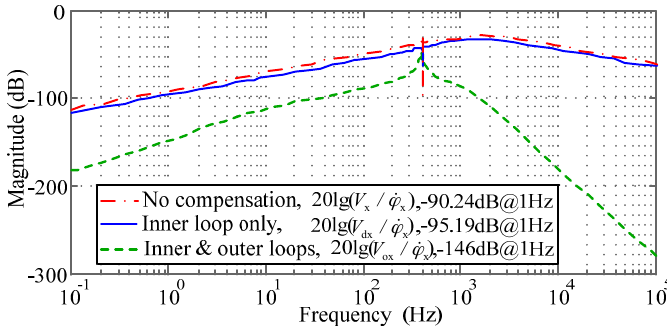
Figure 4. Comparison of the cross-axis frequency responses with and without decoupling compensation. The calculation of 20 lg( V x /